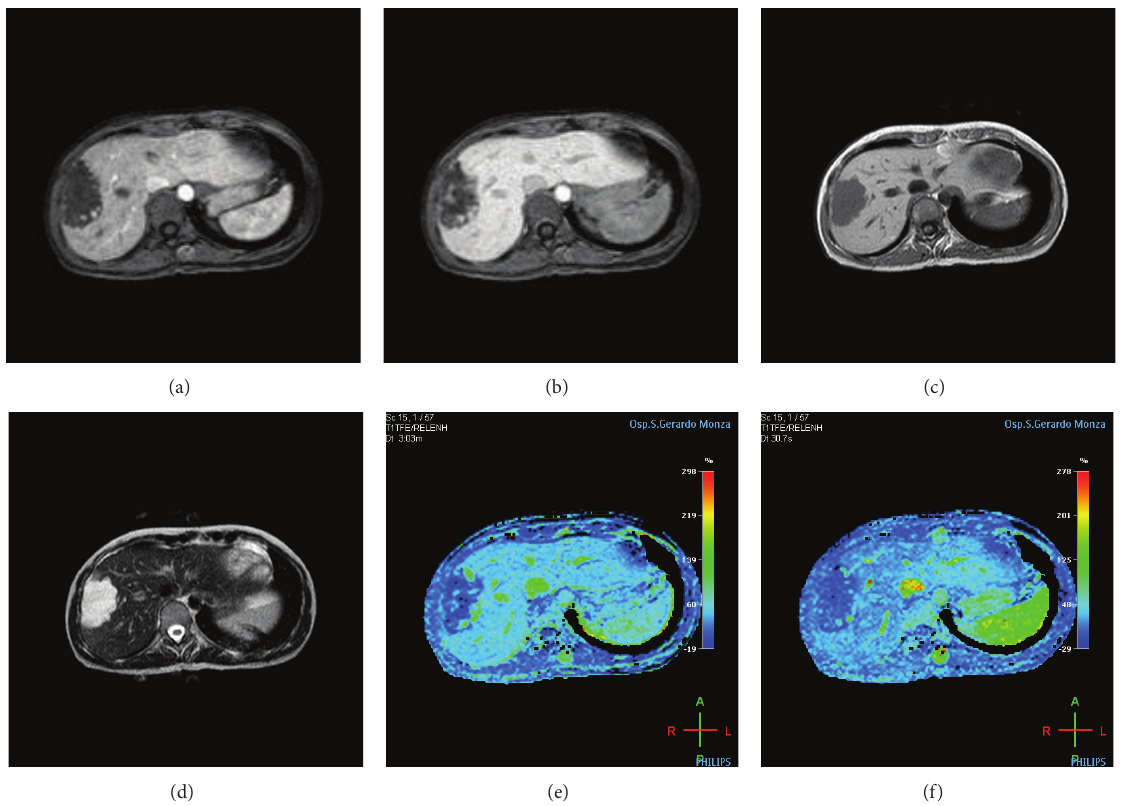
Figure 1: A 44-year-old man with gallbladder stones was evaluated. The MR imaging shows a focal lesion in the right lobe. (a, b) Axial arterial and delayed postcontrast injection images show irregular well-defined lesion, characterized by globular pattern enhancement at the periphery of the lesion in the arterial phase, with intensity signal that increases during delayed phase. (c) Axial T1-weighted in-phase echo-gradient sequence shows a homogeneous hypointense well-defined irregular nodular area in the seventh segment. (d) Axial T2 fat-sat weighted sequence shows well-defined nodular area, with high intensity signal. (e, f) On colour perfusion maps (Relative Arterial Enhancement and Relative Late Enhancement, resp.) the lesion corresponds to hypovascularized area, characterized by high vascularity hot-spots signals along the boundary of the